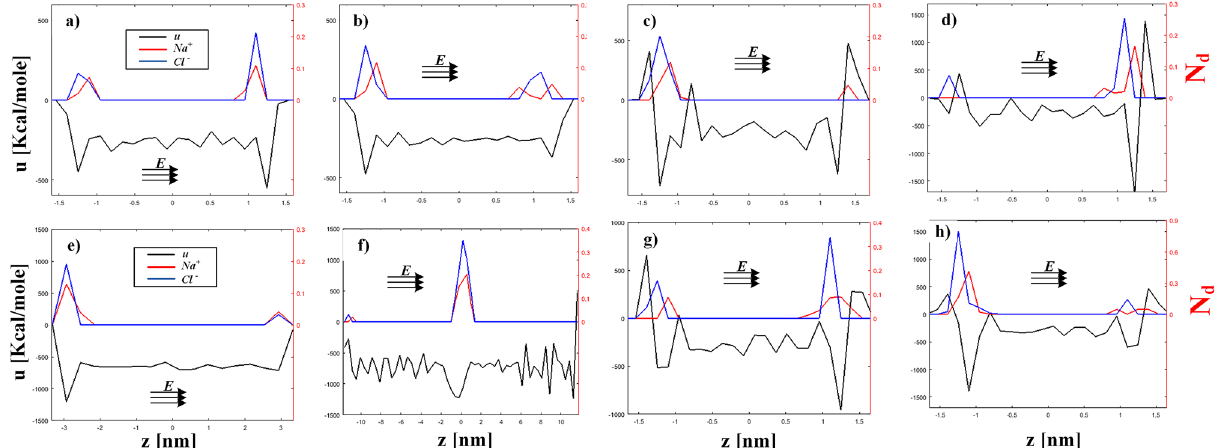
Figure 2. Potential energy for ion/water solution ( c = 0.58 M, unless otherwise stated), in comparison with ion mass density, N d . Blue and red lines denote Cl − and Na + mass density, respectively, and refer to the right vertical axis. Black line is the calculated potential energy (left vertical axis). Potential values are averaged over the xy - directions. Simulation conditions are: ( a ) E z = 0.001 V/nm, h = 3 nm, ε wf /ε ff = 0.1 ( b ) E z = 0.1 V/nm, h = 3 nm, ε wf /ε ff = 0.1 ε wf /ε ff = 0.1, ( d ) E ε wf /ε ff = 1.0 , ( e ) , ( c ) E z = 1.0 V/nm, h = 3 nm, z = 1.0 V/nm, h = 3 nm, E z = 0.1 V/nm, h = 6 nm, ε wf /ε ff = 0.1 , ( f ) E z = 0.1 V/nm, h = 21 nm, ε wf /ε ff = 0.1 , ( g ) E z = 0.1 V/nm, h = 3 nm, ε wf /ε ff = 0.1 , c = 0.92 M, ( h ) E ε wf /ε ff = 0.1 , c = 1.84 z = 0.1 V/nm, h = 3 nm,